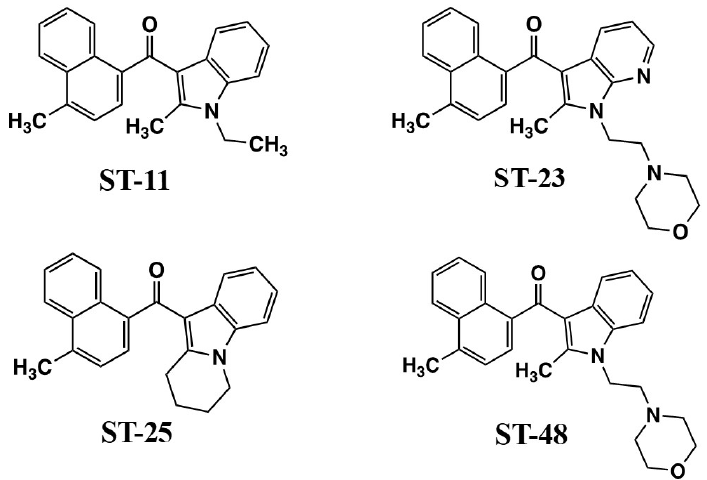
Figure 6. The Stella naphthoyl indoles and analogs.